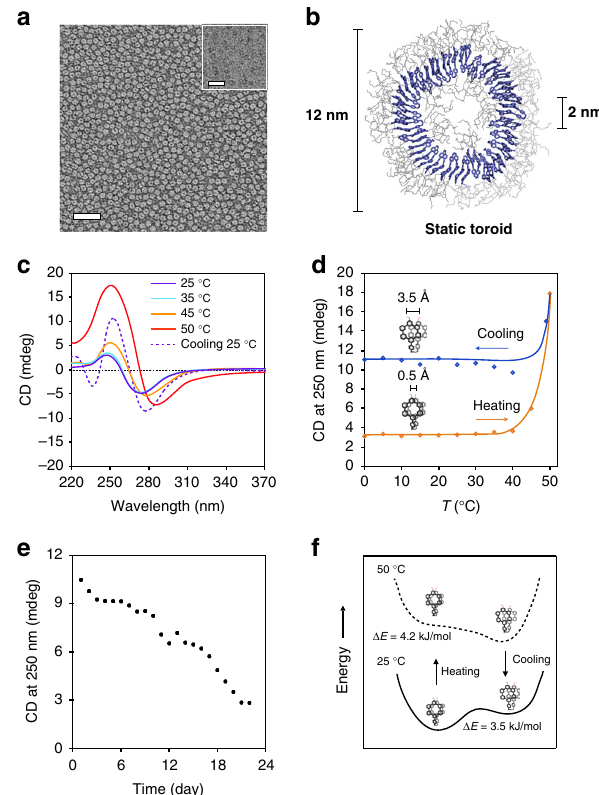
Fig. 2 Characterization and activation of toroids by heat treatment. a Negatively-stained TEM image (scale bar, 50 nm; inset, cryo-TEM image, scale bar, 25 nm) of toroids formed by 1 S (30 μ M) in aqueous (10 vol% THF) solution. b Calculated static toroidal structure from MD simulations. c Temperature-dependent circular dichroism (CD) spectra of 1 S (30 μ M) in aqueous (10 vol% THF) solution. d Thermal hysteresis of 1 S , temperature- dependent CD intensity changes at 250nm (orange, heating curve; blue, cooling curve). e Relaxation of 1 S , time-dependent CD intensities at 250 nm after heating to 50 °C and then cooling to room temperature. f